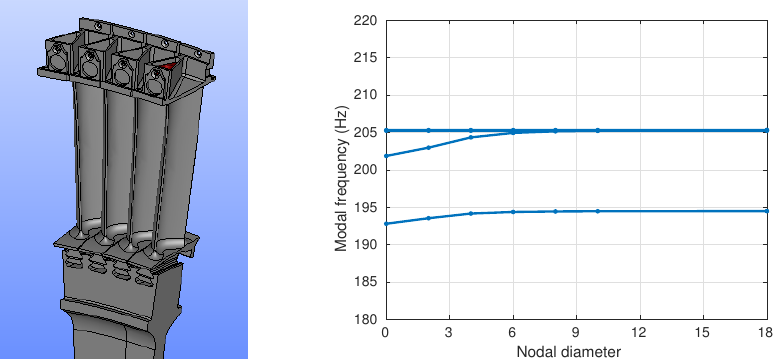
Figure 9. FEM model of the LPT rotor sector; mistuning mass shown in red ( left ), and vibration frequencies of the four first modal families ( right ) for the mistuning configuration [0001]. The BTT measurements corresponding to the mistuning pattern [0001] with a forcing with EO4 are presented in Figure 10. The same switching between the FR and flutter solutions is observed and, again, the synchronous solution clearly dominates the response near the resonance, with two resonance peaks that are in good agreement with the FEM- computed frequencies (dashed lines in Figure